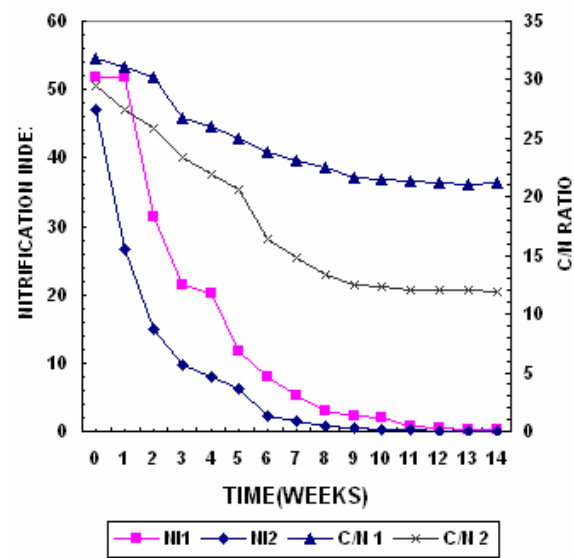
Fig 2: Variation of Nitrification Index and C/N Ratio during